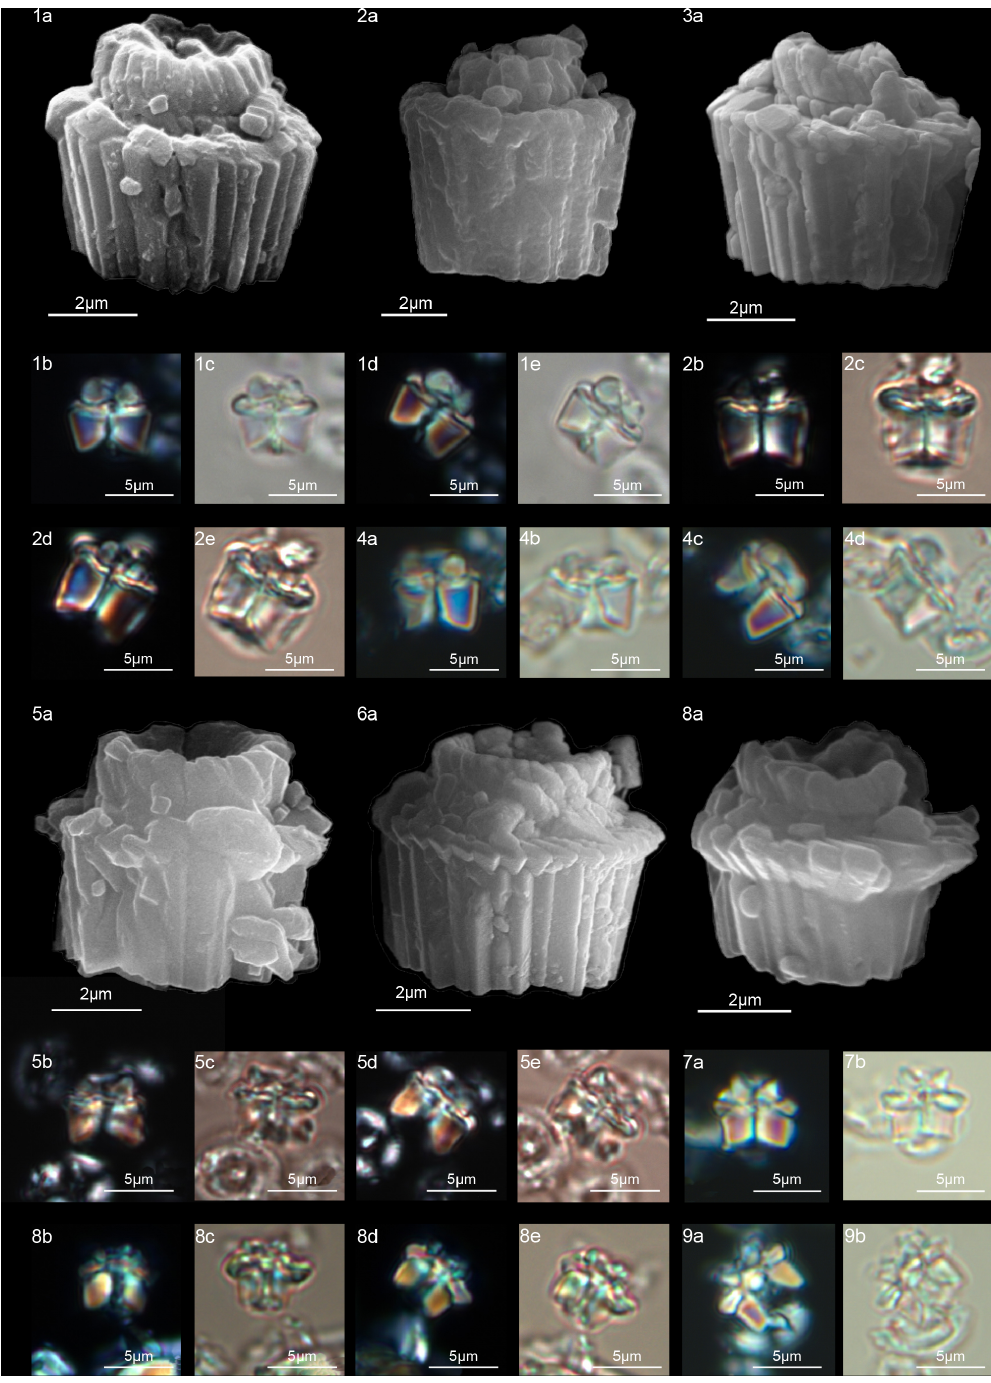
Figure 16. Lithoptychius galeottii . (1) Holotype (IGF 104722). Sample: 1209C 14-1, 56–57. (1a) SEM, (1b, d) XPL, (1c, e) PPL. (2) Paratype (IGF 104723). Sample: 1209B-24-5, 8–9. (2a) SEM, (2b, d) XPL, (2c, e) PPL. (3) Sample: 1267B 29-5, 84–85. SEM. (4) Sam- ple: 1267 B 29-5, 84–85. (4a, c) XPL, (4b, d) PPL. Lithoptychius felis. (5) Sample: 1209C 14-1, 56–57. (5a) SEM, (5b, d) XPL, (5c, e) PPL. (6) 1262C 10-6, 23–24. SEM. (7) Sample: 1209C 14-1, 116–117. (7a) XPL, (7b) PPL. Lithoptychius schmitzii . (8) Sample: 1209C 14-1, 84–85. (8a) SEM, (8b, d) XPL, (8c, e) PPL. (9) Sample: 1209C 14-1, 80–81. (9a) XPL, (9b) PPL. See Table S1 for sample